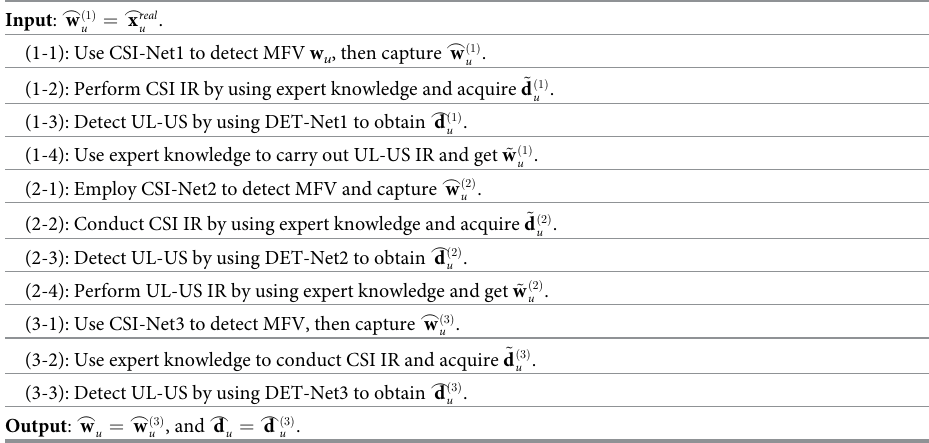
Table 2. Processing